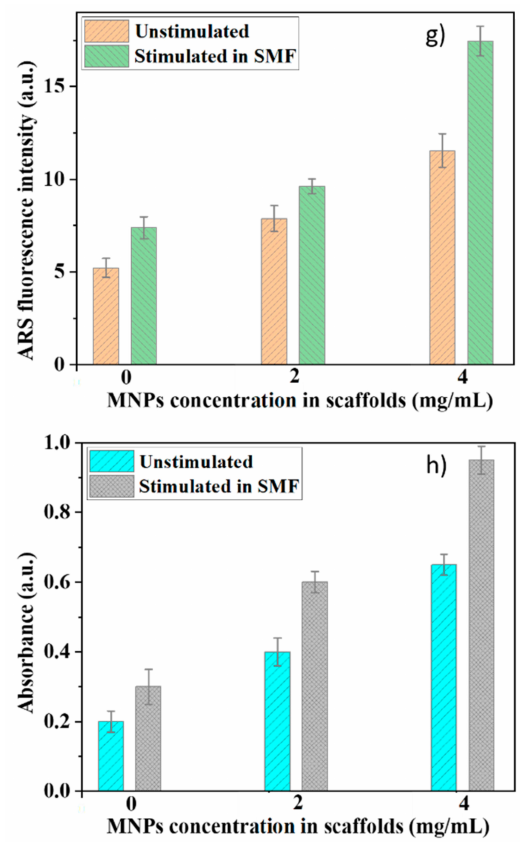
Figure 8. Alizarin Red Staining (ARS) staining of the cell-seeded sca ff olds with MNPs concentration of: ( a , d ) 0 mg / mL; ( b , e ) 2mg / mL; ( c , f ) 4 mg / mL, after 20 days of incubation. Upper panel), unstimulated sca ff olds. Lower panel, sca ff olds exposed to SMF; ( g ) ARS fluorescence intensity as determined by ImageJ; ( h ) absorbance measurements for ARS marking of the mineral deposits in cells growing on sca ff olds with di ff erent MNPs concentrations (except for the sca ff olds without MNPs, the results were statistically significant ( p <